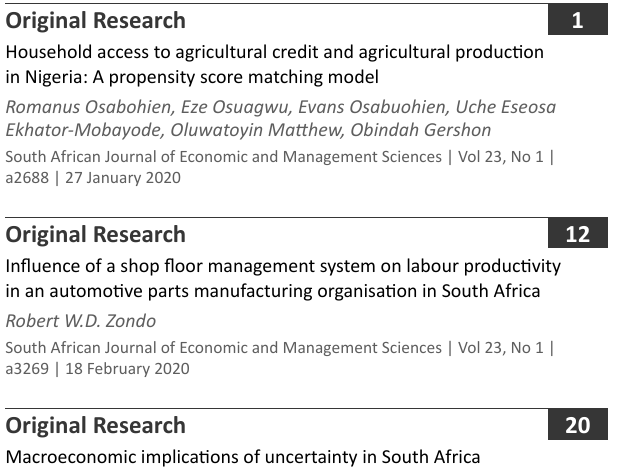
Household access to agricultural credit and agricultural production in Nigeria: A propensity score matching